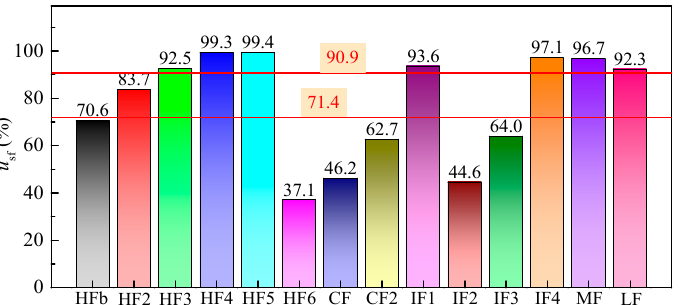
Figure 12. The strength uses efficiency u sf of different deformed steel fibers. The u sf of HF6 is only 37%. This indicates that the fiber strength has not fully